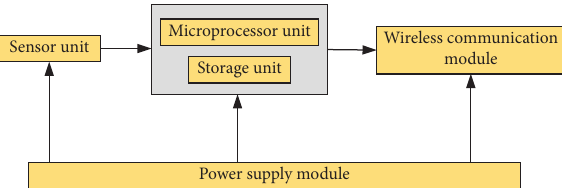
Figure 2: System hardware framework